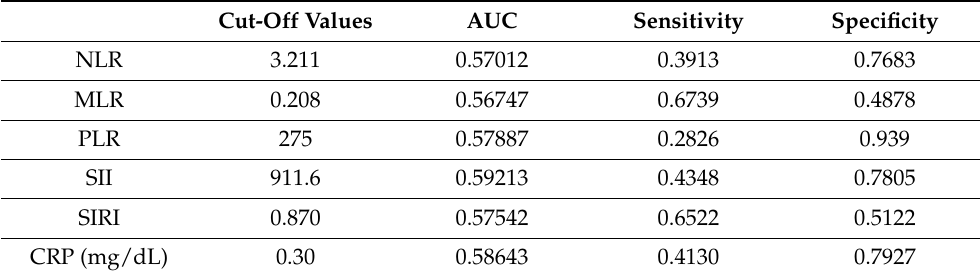
Figure 1. Correlations between peripheral blood parameters or systemic inflammatory markers and PASI scores are shown. Solid lines indicate linear regression lines. Spearman’s rank correlation coefficient (r) was used for correlation analyses. Table 2. Cut-off values and AUC from ROC curves for discriminating PsV and